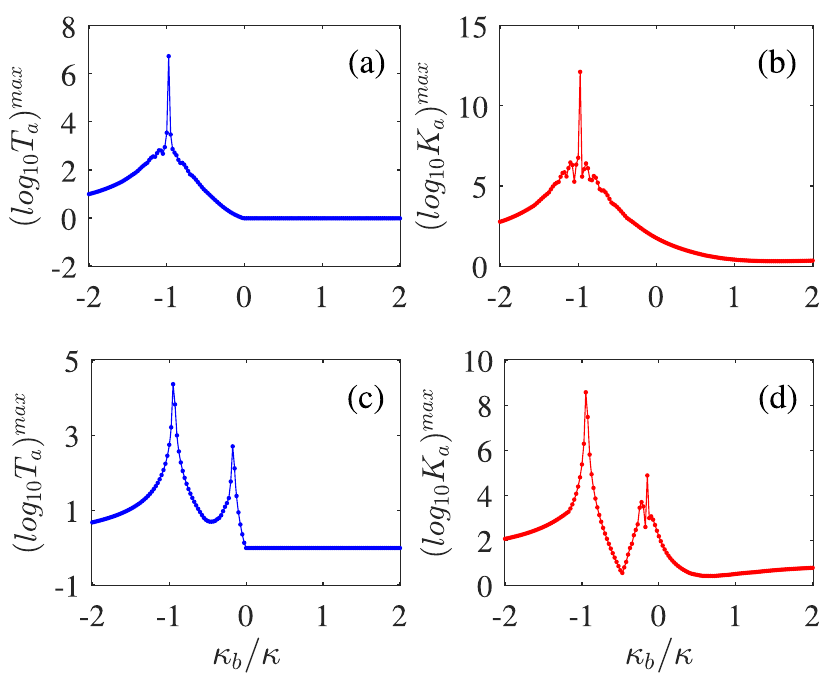
Figure 4. The maximal logarithms of the linear transmission rate T a ( a , c ) and the third-order nonlinear intensity K a ( b , d ) versus the intrinsic decay rate κ b for g = 0.45 κ ( a , b ) and g = 0.2 κ ( c , d ). Other parameters are the same as those in Figs 2 and